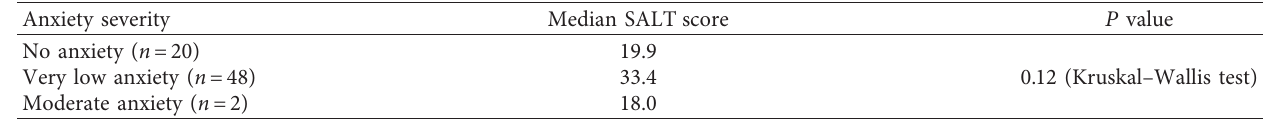
Table 3: Relation between anxiety and SALT score.